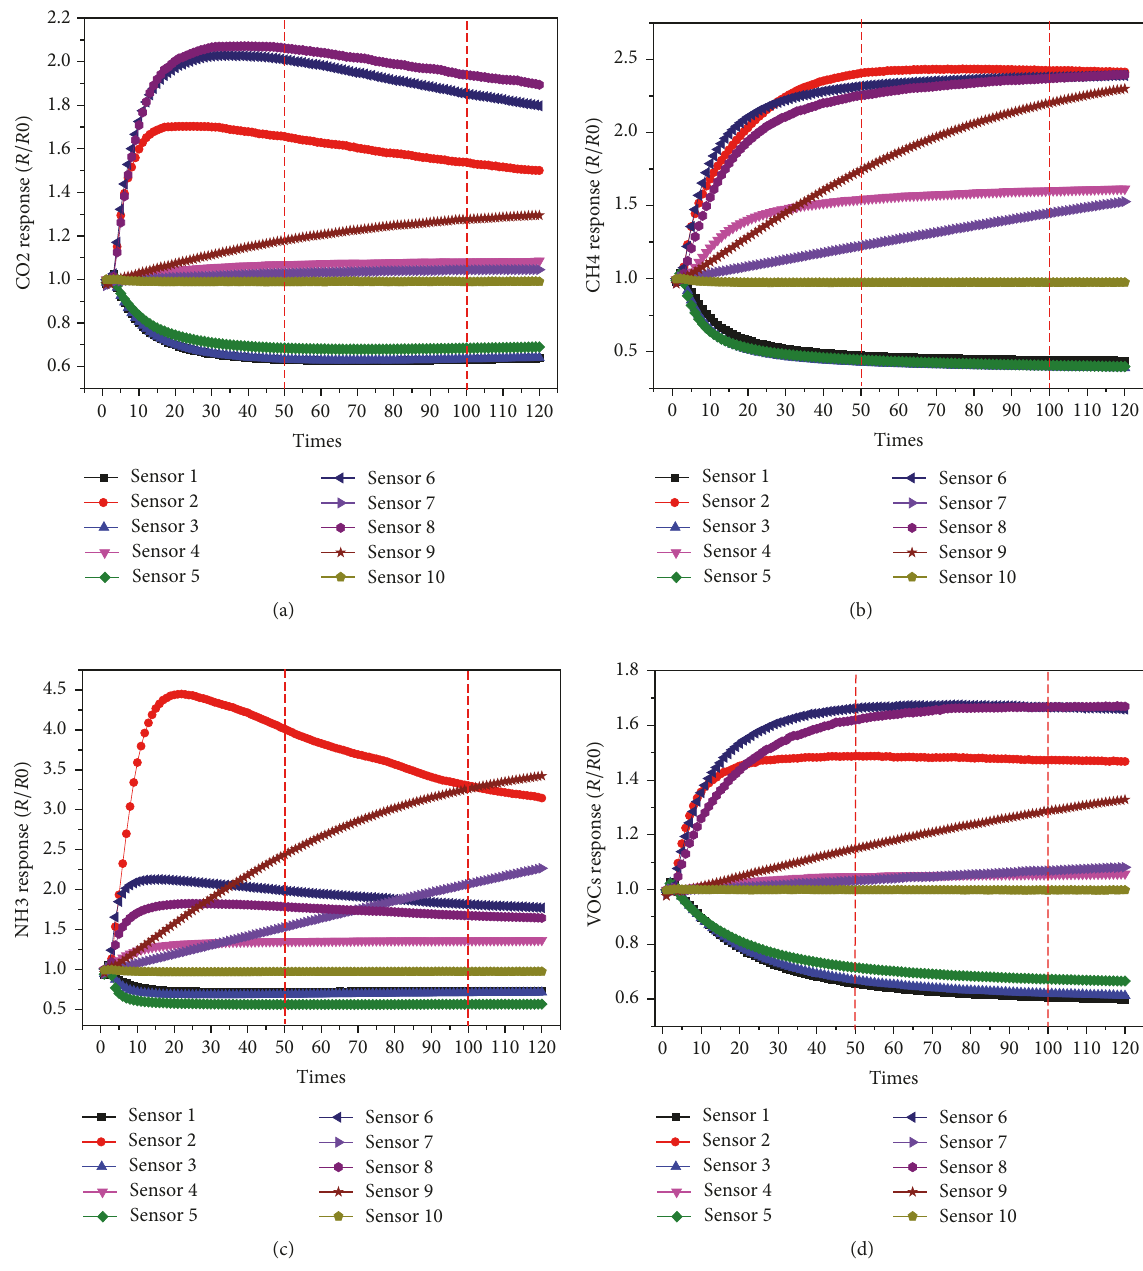
Figure 2: The sensor response map of CO 2 , CH 4 , NH 3 , and VOC S corresponds to (a), (b), (c), and (d), respectively, when the concentration was 300 ppm. The horizontal axis stands for the sampling time (0–120 s) and the vertical axis denotes the amplitude of sensor output impedance